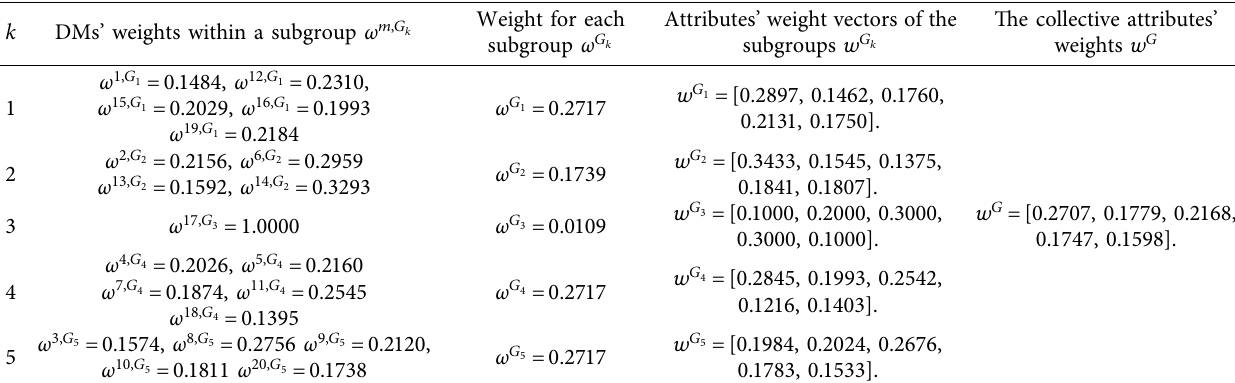
Table 9: .e final weights without considering the interactive